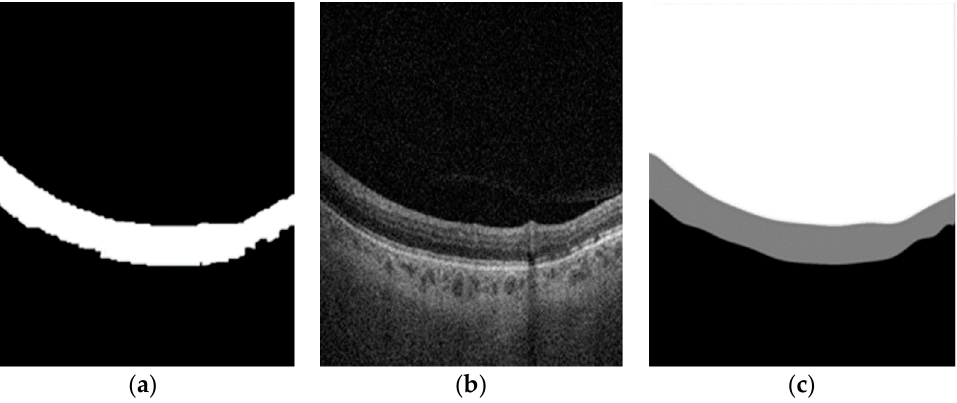
Figure 3. The result of the optical coherence tomography (OCT) fundus image processing: ( a ) original OCT image against the background of noise; ( b ) preliminary segmentation of the retinal layer; ( c ) fundus image model based on parametric functions.